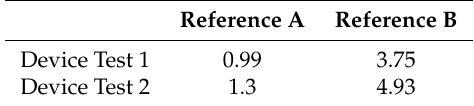
Table 2. Comparative concentrating factors for each tested system compared to References A and B.